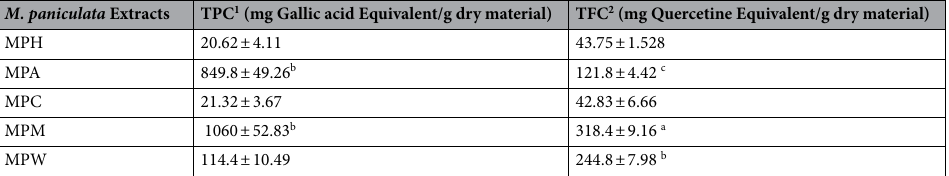
Table 1. Quantification of total Phenolic and Flavonoid contents in M. paniculata leaves extracts. 1 Total phenolic content and 2 Total flavonoids content expressed as Mean ± SE (n = 3). The superscripted alphabets represent the number of extracts over which the values of the given extract are very highly significant (***). a : four extracts, b : three extracts, c : two extracts.